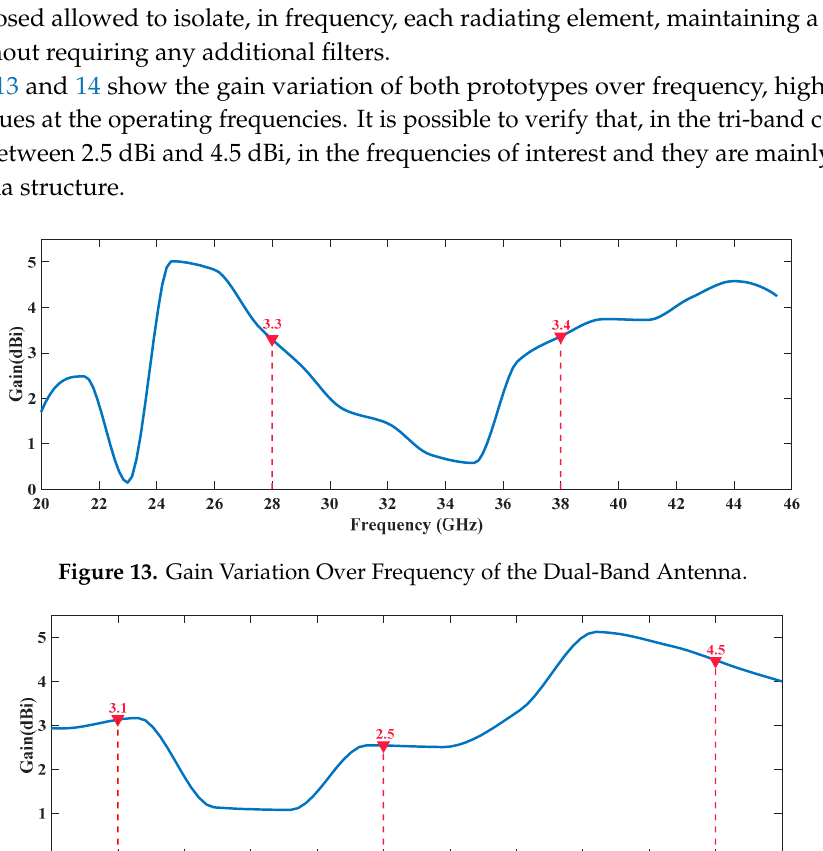
Figure 12. Surface Current Distribution at ( a ) 20 GHz, ( b ) 28 GHz and ( c ) 38 GHz.